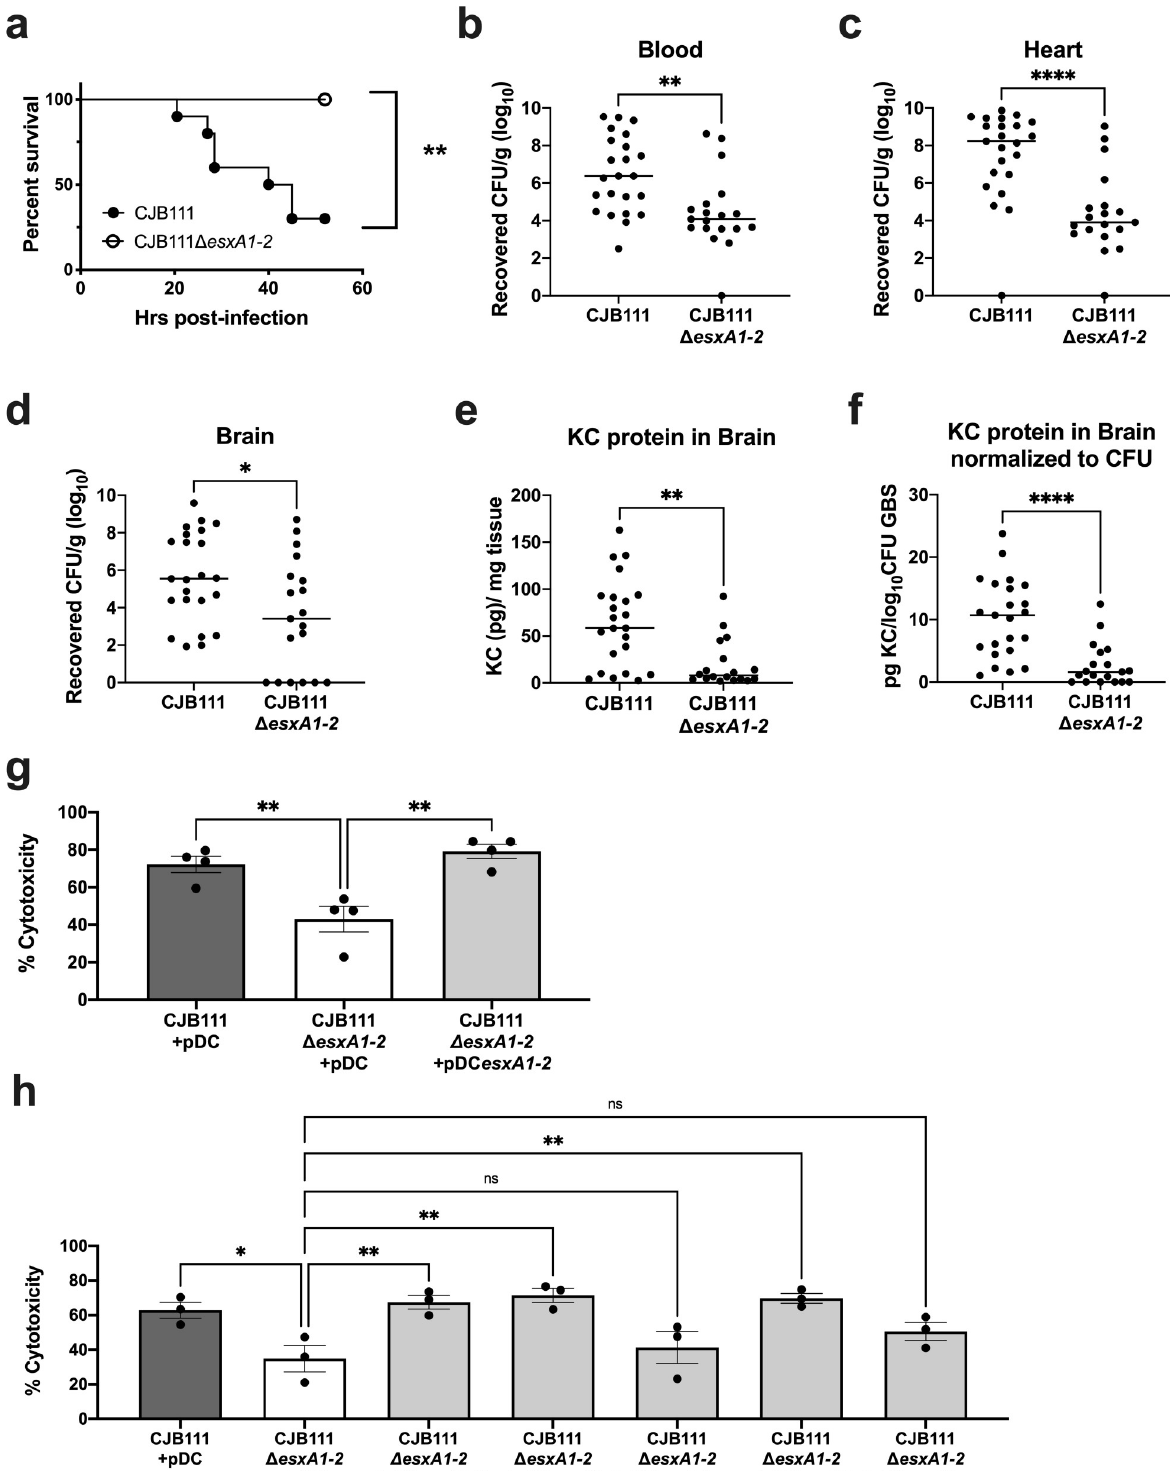
Fig 5. EsxA contributes to CJB111 virulence and cytotoxicity. a) Representative survival curve of 8 week-old CD1 male mice tail-vein injected with CJB111 or CJB111 Δ esxA1-2 , n = 10 mice/ group. Statistics reflect the Log rank (Mantel-Cox test), p < 0.01, �� . Animal experiment was performed three independent times. Recovered CFU counts from the b) blood and c) heart, and d) brain tissue of infected mice. e) KC protein levels quantified from infected brain tissue by ELISA, and f) normalized to the log 10 CFU within each brain. In panels b-f , each dot represents